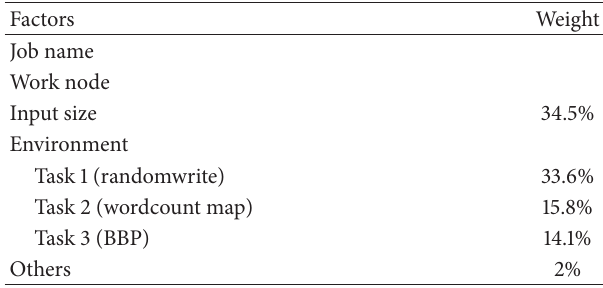
Table 2: A rough weight scheme for job